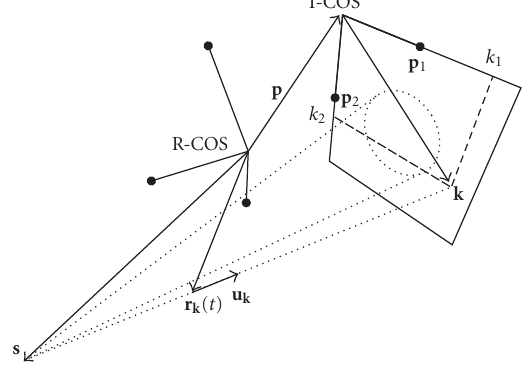
Figure 3: Cone-beam projection